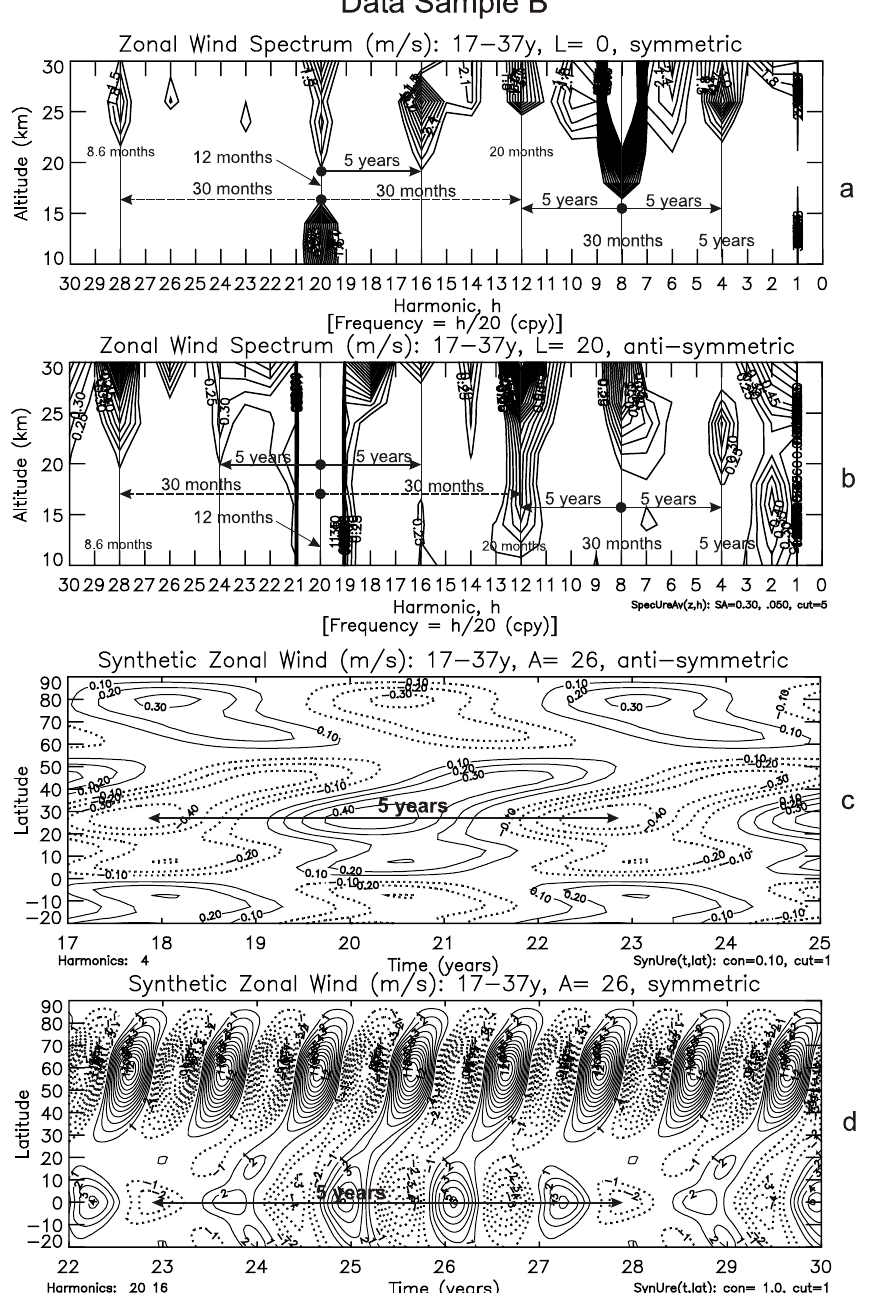
Fig. 1, the harmonics, h, associated with particular periods are half as large (e.g., h=20 for 12-month AO). (a) (b) Spectra show pronounced signatures of AO, 30-month QBO, and 5-year oscillation. Virtually every signature is identified to indicate that we have a reasonably good understanding of how the spectral features are generated. Compared to Fig. 1, the 5-year side lobe at h=16 (a) is 50% larger due to the stronger 30-month QBO. (c) Synthesized 5-year anti-symmetric oscillation for h=4 shows small wind velocities at 26km altitude; but its non-linear interaction with the strong anti-symmetric AO (h=20) could produce the symmetric side lobe in Fig. 3a. (d) Synthesis describes the latitudinal variations of the modulated symmetric AO at 26km, essentially in phase with the results shown in Fig.